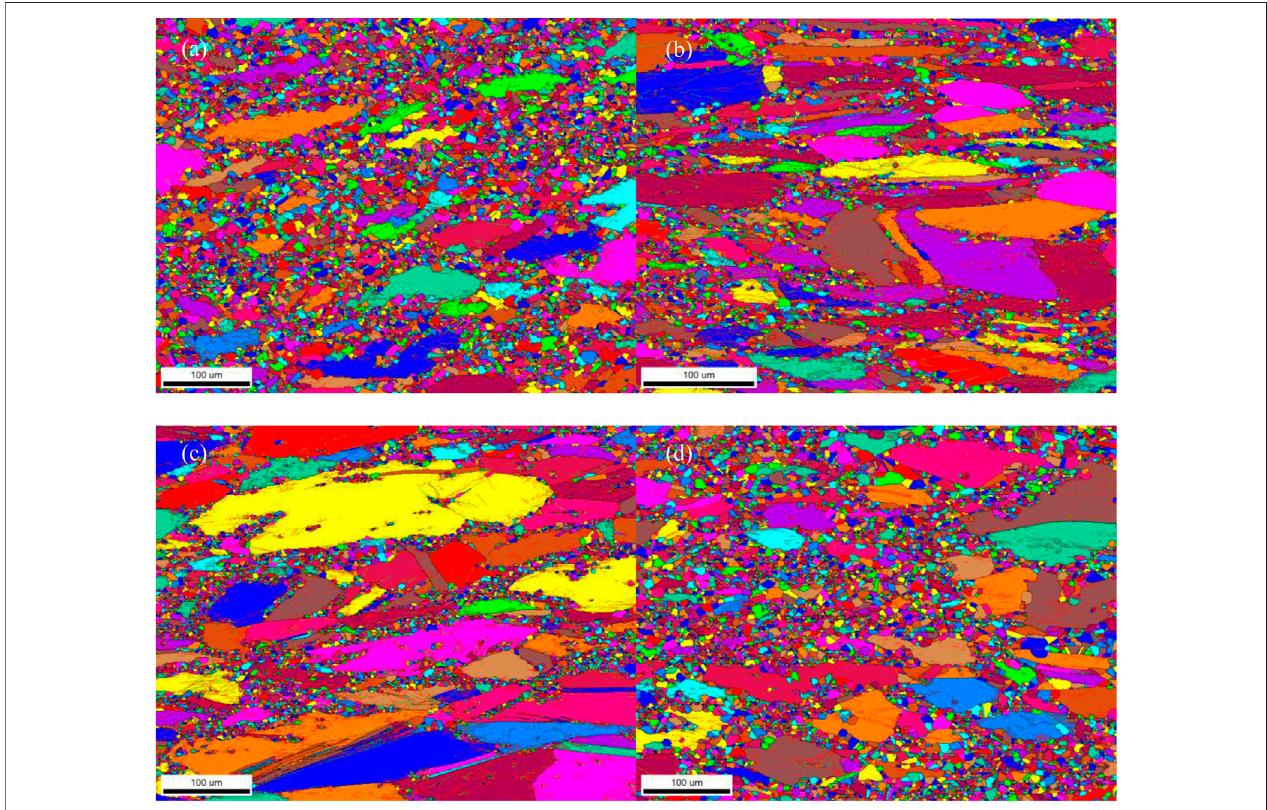
FIGURE 6 | Typical OIM maps of the Co – Ni – Cr – W – based superalloy deformed to a true strain of 0.7 at different strain rates with the temperature of 1,100 ° C: (A) 0.01 s − 1 , (B) 0.1 s − 1 , (C) 1 s − 1 , and (D) 10 s − 1 .